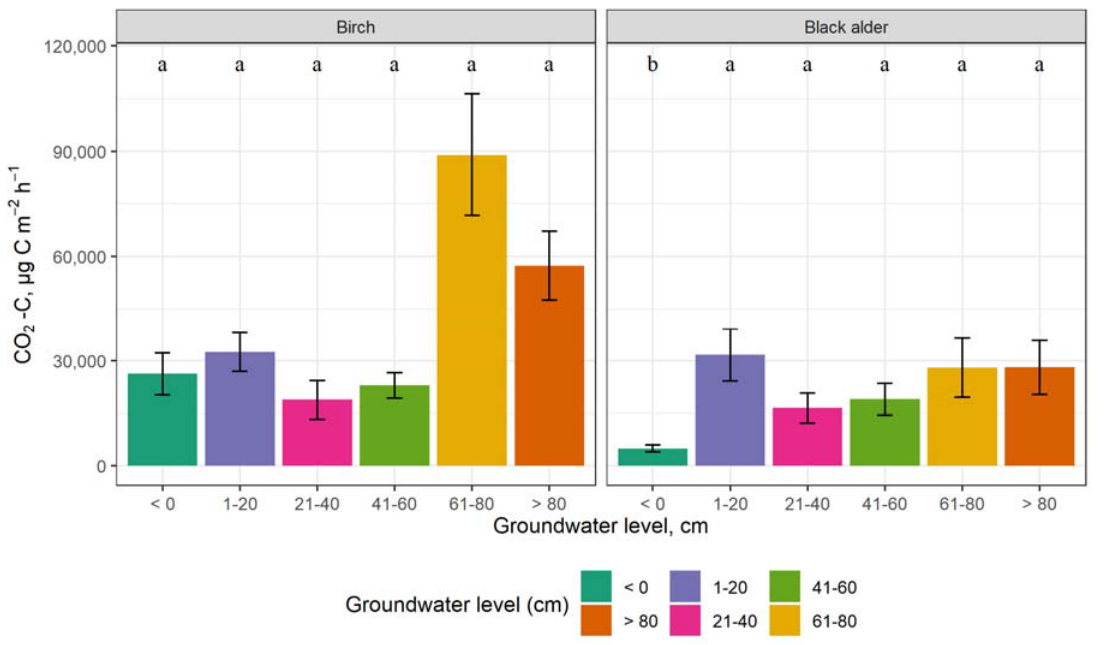
Figure 9. CO 2 fluxes depending on the groundwater level in silver birch and black alder stands. Different lowercase letters show statistically significant differences ( p < 0.05, two-sample t -test) between tree species within the same groundwater level group.